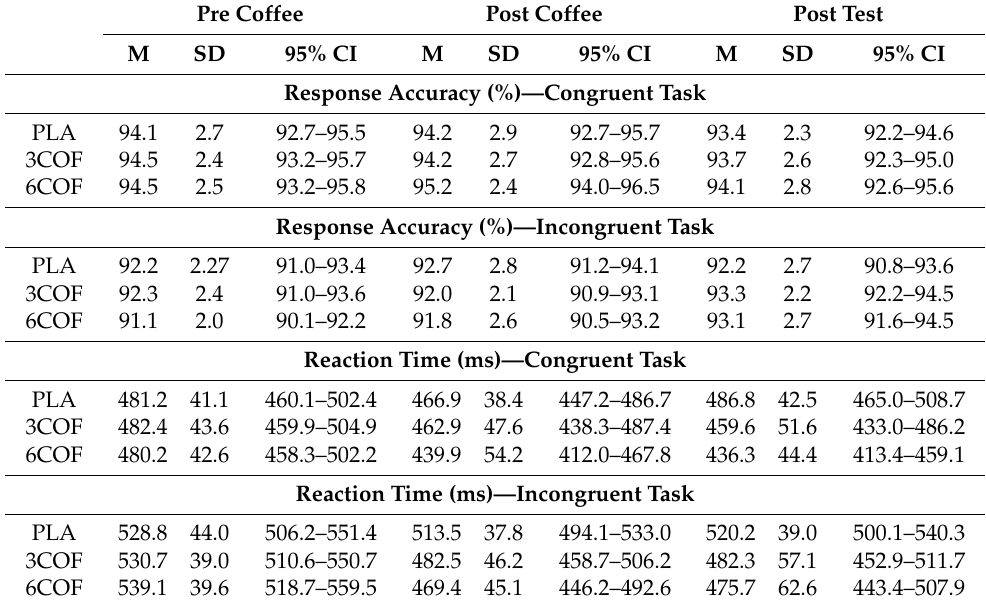
Table 3. Cognitive